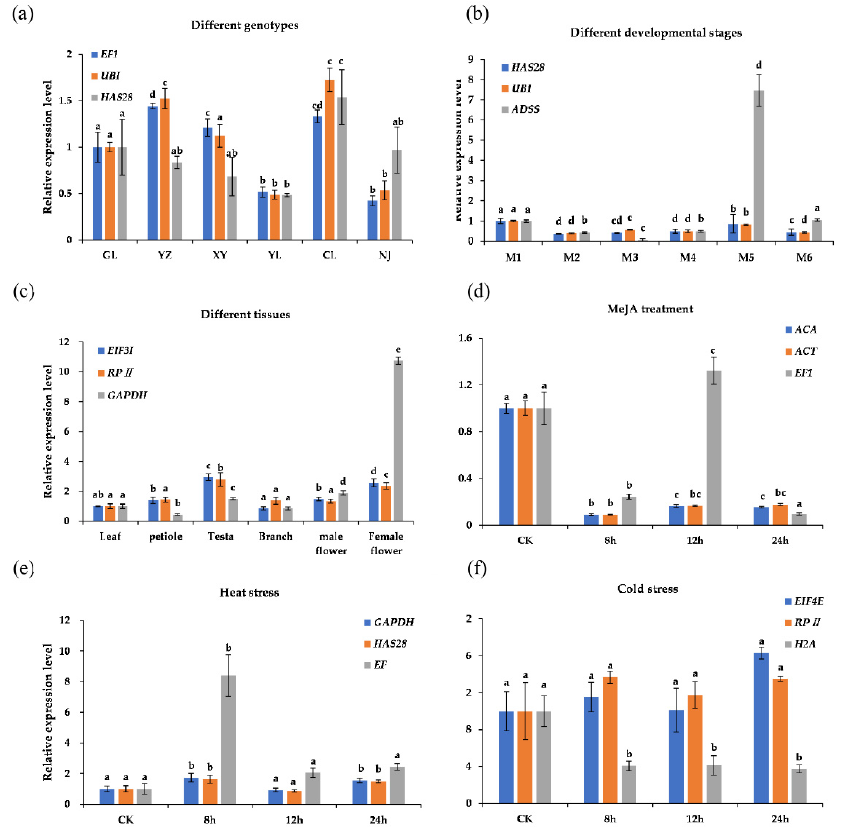
Figure 5. Relative expression levels of the GbCHS target gene in all samples under di ff erent experimental conditions. In each bar chart, the blue and orange bars represent the two best reference genes, and the grey bars represent the worst. ( a ) Di ff erent genotypes, ( b ) di ff erent developmental stages: M1–M6 represent May, June, July, August, September, and October respectively, ( c ) di ff erent tissues, ( d ) MeJA treatment, ( e ) heat stress, and ( f ) cold stress. CK means control. The error bars and di ff erent letters above the bars indicate the standard deviations (SDs) and significant di ff erences ( p <